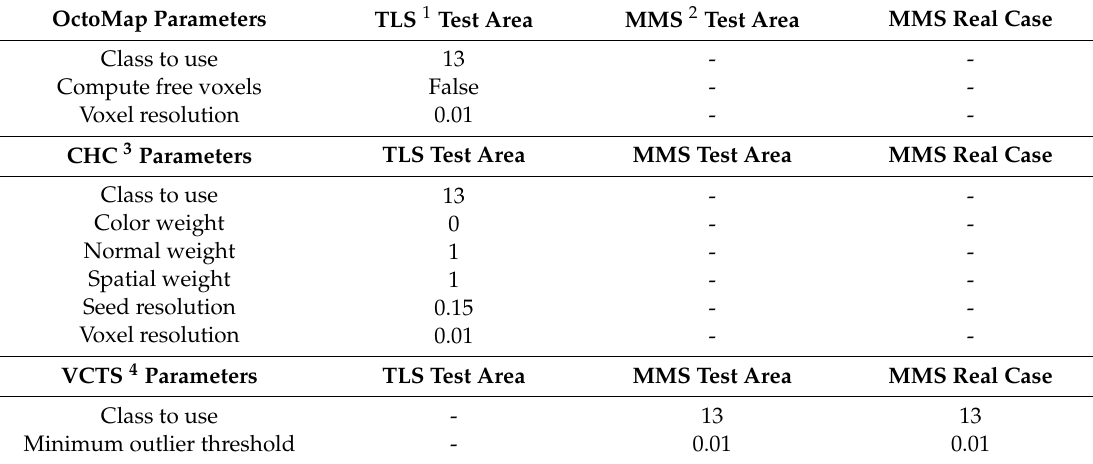
Table 9. List of the utilized parameters in the volume calculation algorithms.